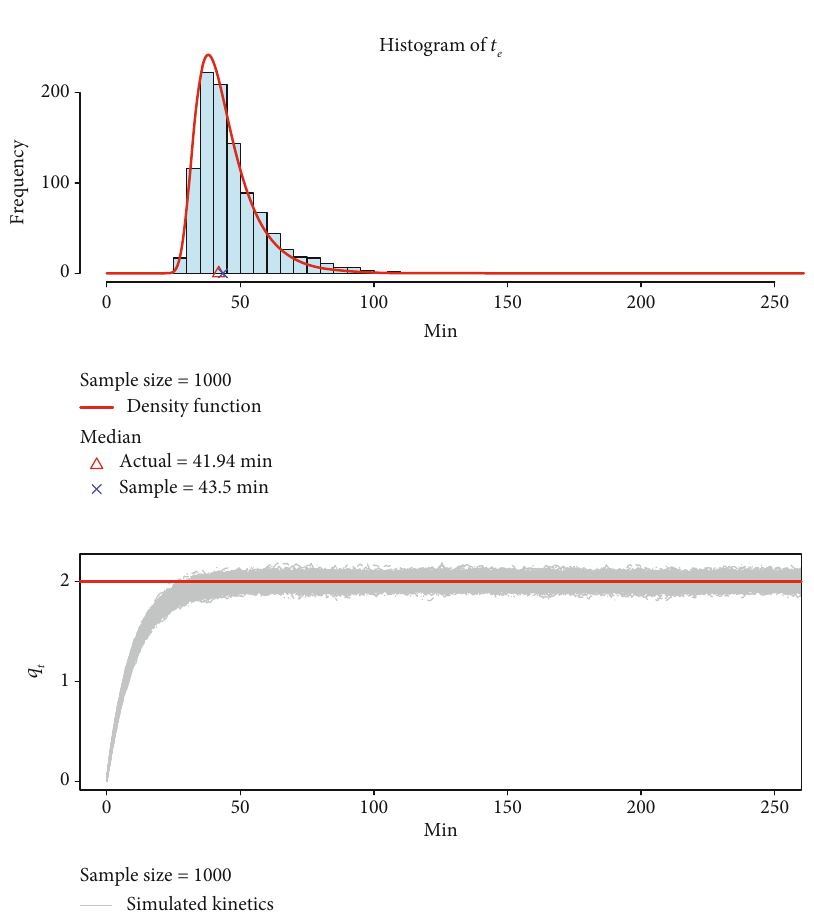
Figure 1: Adsorption kinetics obtained based on computer simulation (bottom) and the empirical distribution of the time required to reach the equilibrium state (top). The parameters used in the simulation are q